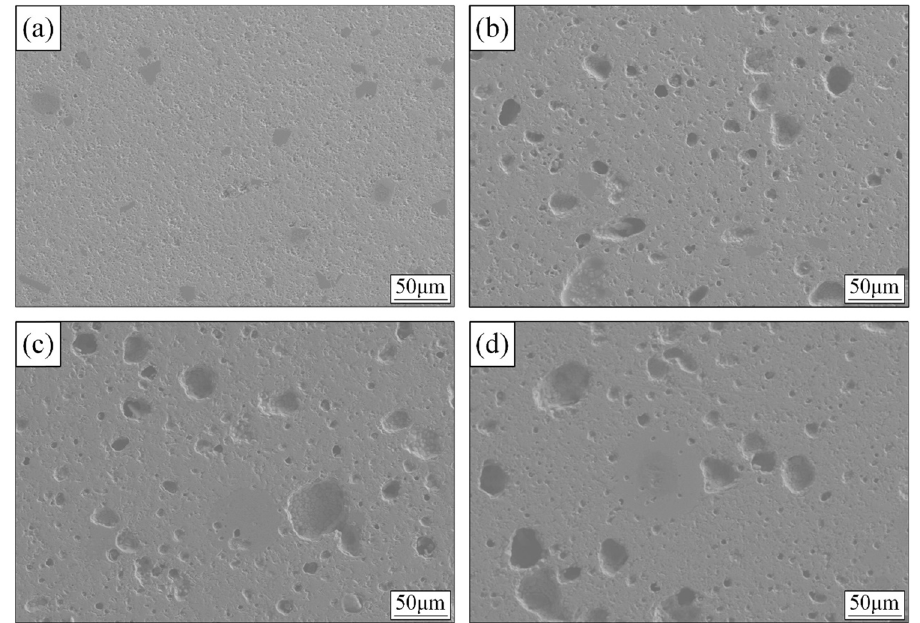
Figure 3: SEM image of briquettes fi red at 1,250°C with di ff erent basicity values ( a ) basicity = 0, ( b ) basicity = 0.33, ( c ) basicity = 0.83, and ( d ) basicity =